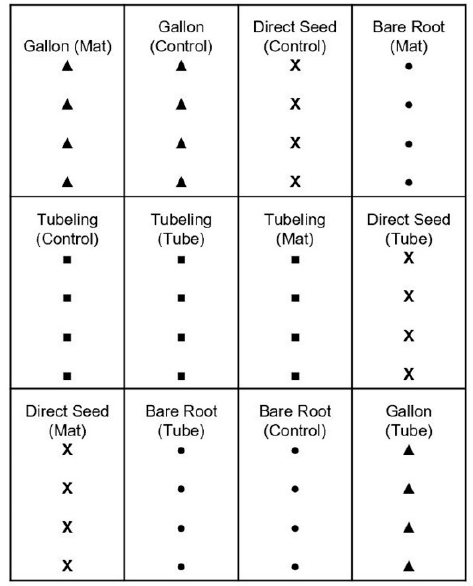
Figure 3. An example of the field layout of one experimental unit containing one site-preparation technique (entire rectangle), and each internal rectangle representing one unit consisting of the planting stock and planting aid treatments. This pattern was repeated five times within each of the five blocks.